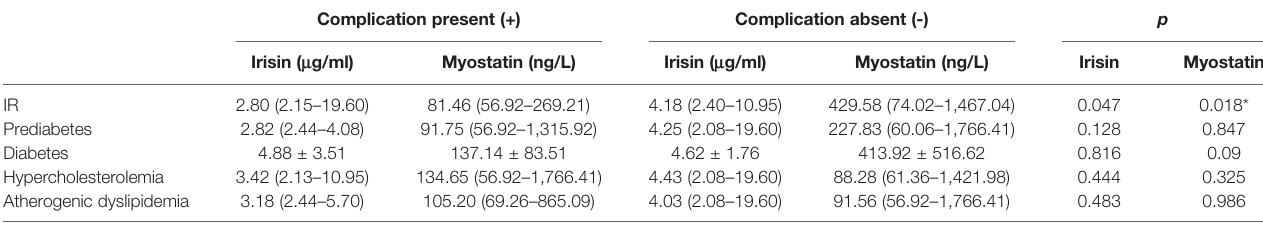
TABLE 4 | Circulating myokine concentrations in acromegaly patients with and without selected complications.